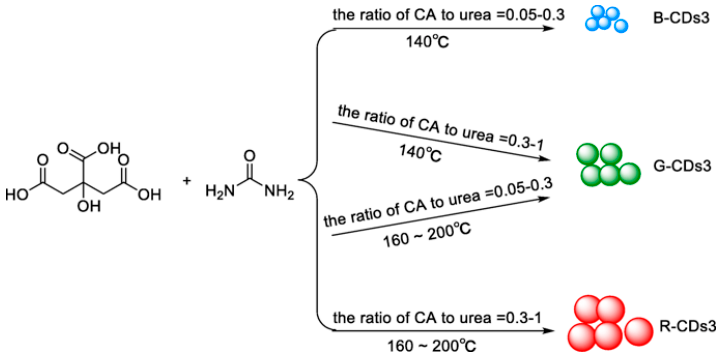
Figure 6. Multicolor-emitting CDs (called as CDs3) by using different molar ratios of CA to urea at